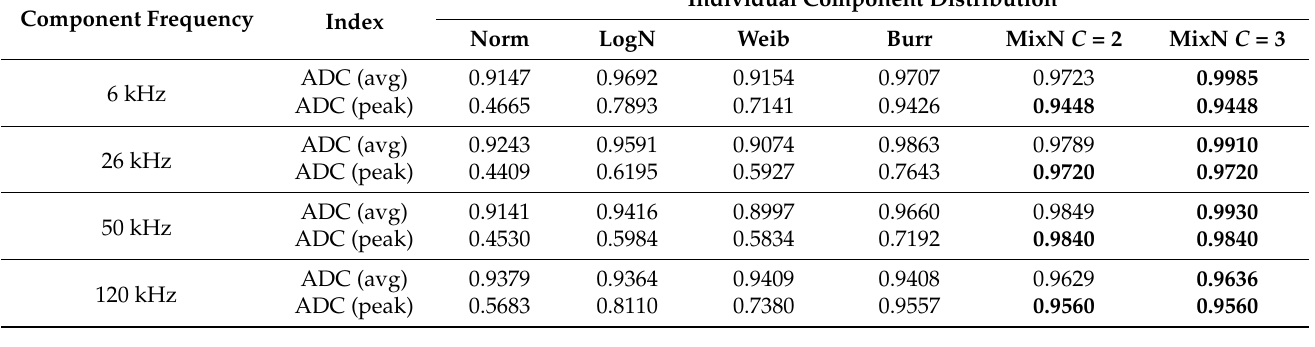
Table 2. Adjusted determination coefficient of the individual component distributions at Alameda. Bold values indicate the best fit.